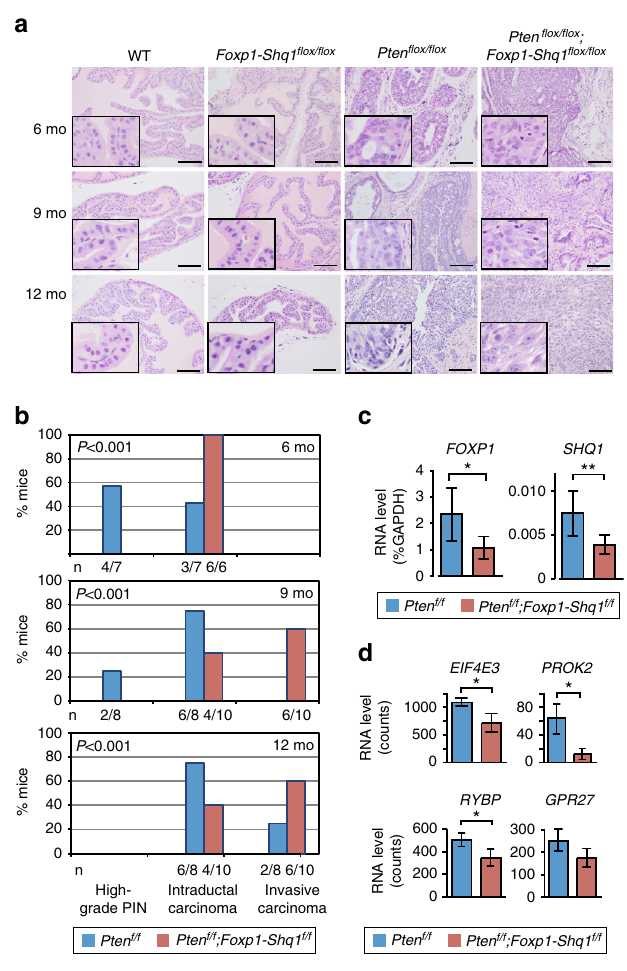
Fig. 2 Foxp1-Shq1 loss cooperates with Pten loss in prostate tumorigenesis. a Comparison of prostate histology (H&E) in wild-type, Foxp1-Shq1 fl ox/ fl ox , Pten fl ox/ fl ox , and Foxp1-Shq1 fl ox/ fl ox ;Pten fl ox/ fl ox mice with Pb-Cre at 6, 9, and 12 months. Scale bars, 50 μ m. Insets show 4× magni fi cation of a portion of the full panel. b Histogram of histology in Pten fl ox/ fl ox (blue; total n = 23; 6 mo, n = 7; 9 mo, n = 8; 12 mo, n = 8) and Foxp1-Shq1 fl ox/ fl ox ;Pten fl ox/ fl ox (red; total n = 28; 6 mo, n = 8; 9 mo, n = 10; 12 mo, n = 10) mouse prostates at 6, 9, and 12 months. The number, n , mice is listed as a fraction of the total n per genotype per time point below each bar. P , Chi-square